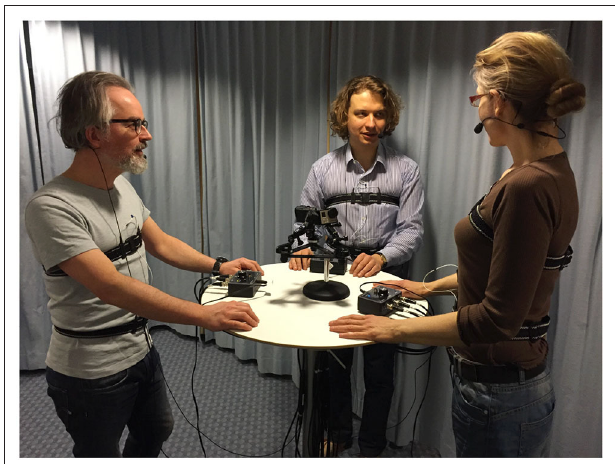
FIGURE 2 | Recording setup in the Stockholm University Respiratory